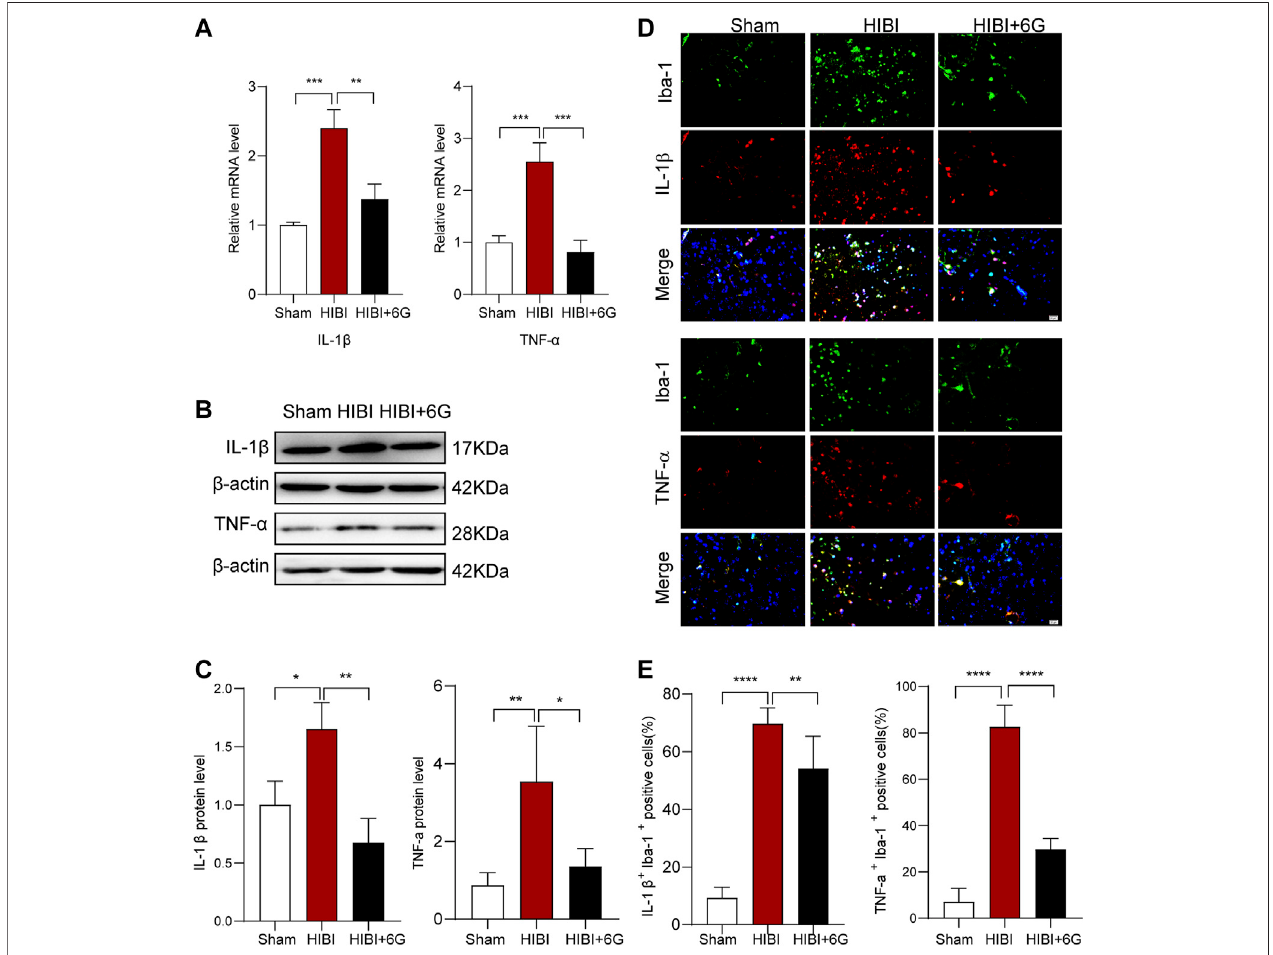
FIGURE3| 6-Gingerolinhibitspro-in fl ammatorygeneexpressionandmicroglialactivationpost-HIBI. (A) Quanti fi cationofthemRNAlevelofIL-1 β andTNF- α inthe brain at 3-day post-HIBI. n (cid:1) 3 per group. (B – C) Representative western blot images and quanti fi cation of IL-1 β and TNF- α expression at 3-day post-HIBI. n (cid:1) 3 – 4 per group. (D – E) Immuno fl uorescent staining of IL-1 β Iba-1 and TNF- α Iba-1, and quanti fi cation of IL-1 α + Iba-1+ and TNF- α + Iba-1+ cells at 3-day post-HIBI, n (cid:1) 6 per group. Scale bar (cid:1) 20 μ m. Data represent the mean ± SEM. * p < 0.05, ** p < 0.01, *** p < 0.001, **** p <